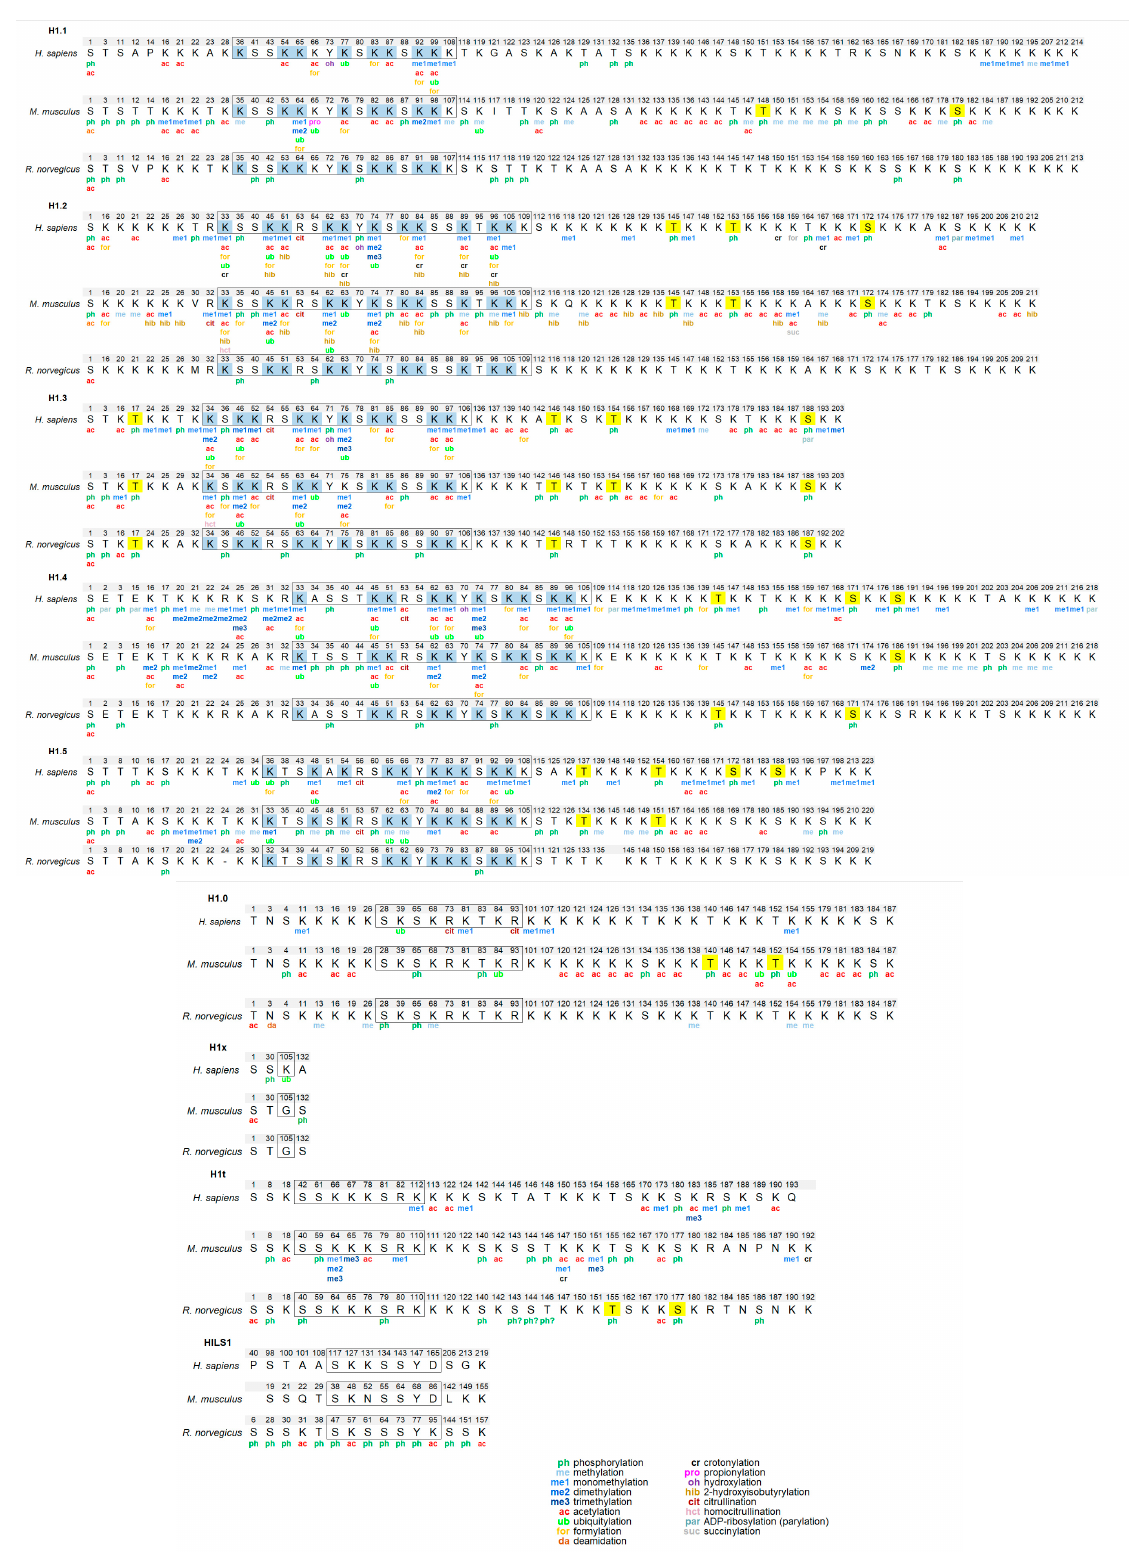
Figure 3. Modified positions in mammalian H1 subtypes. The PTMs are shown based on the sequence alignment of the human, mouse, and rat sequence for each subtype. The residues of the globular domain are shown in the box. In yellow, phosphorylated residues located at CDK-consensus motifs. In blue, PTM-hotspots in the globular domain. The positions refer to the mature protein, which lacks the initial methionine. The complete sequences and the original alignments are shown in Figure